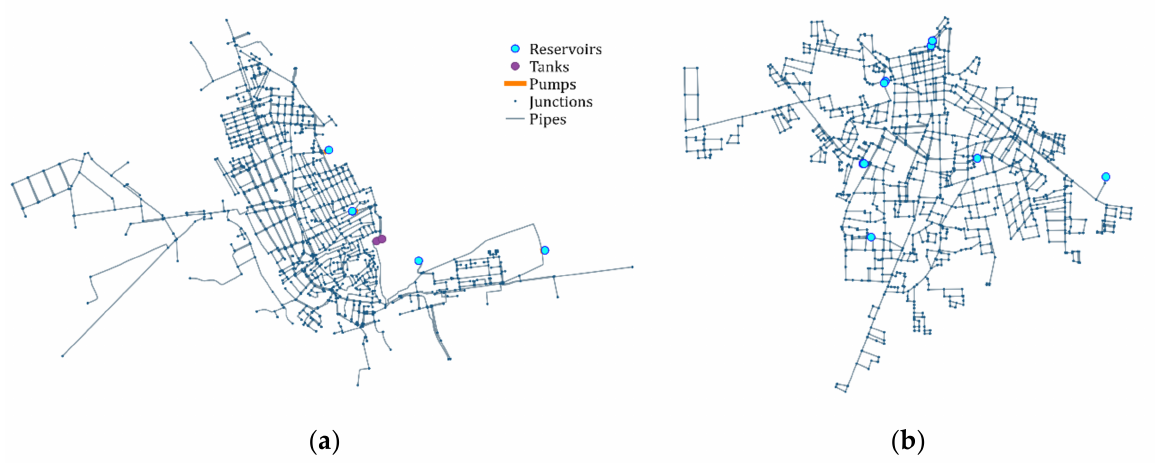
Figure 1. ( a ) Villena network; ( b ) Matamoros